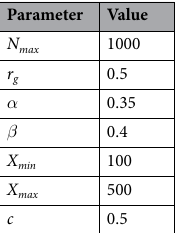
Table 1. CPRG parameters used in the